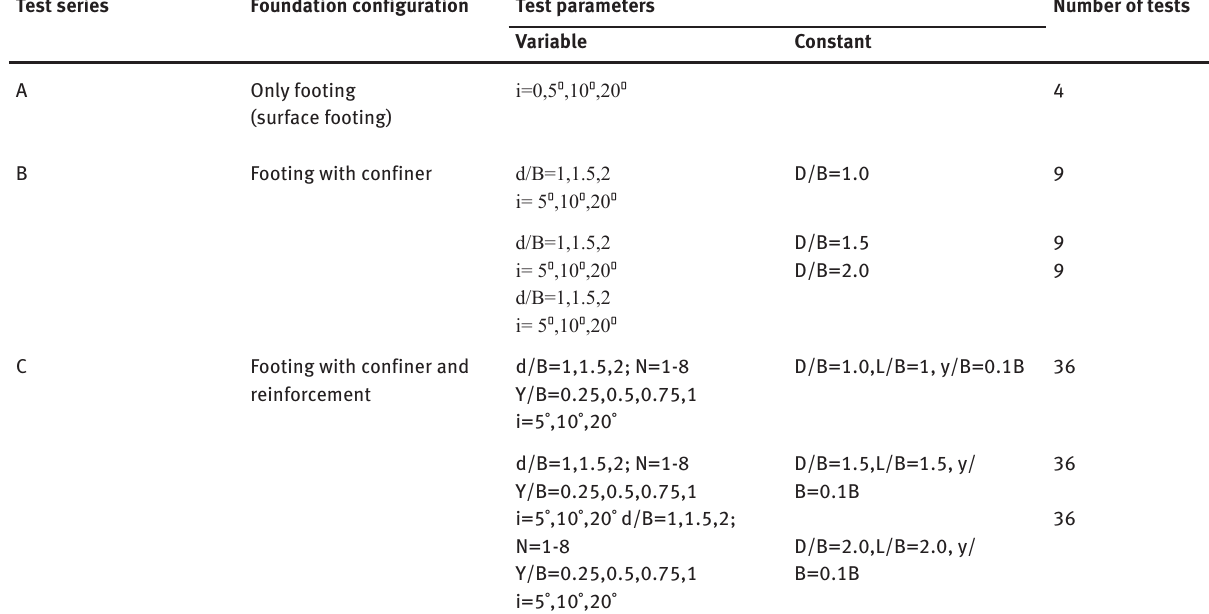
Table 2: Details of laboratory model tests, Test